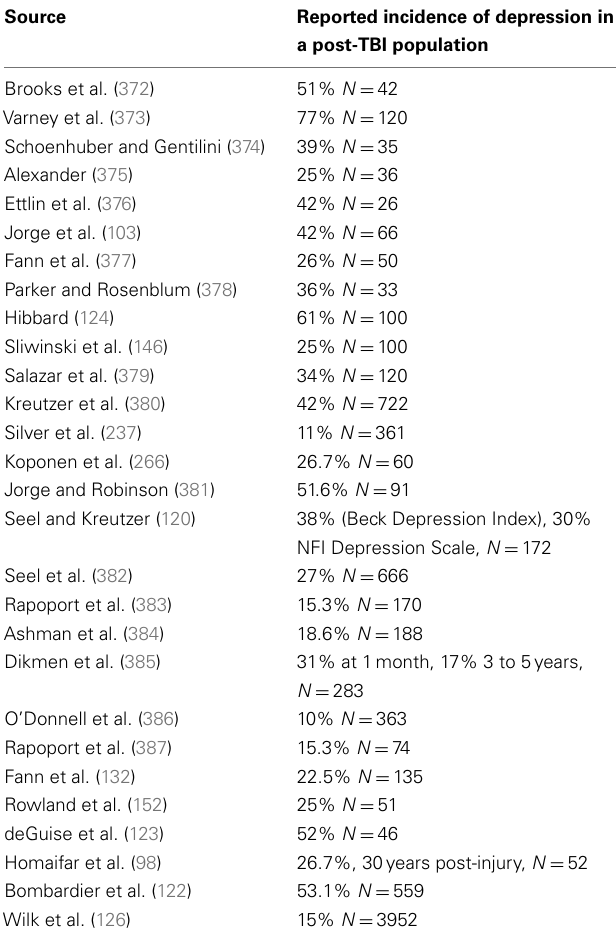
Table 6 | Depressive illness following traumatic brain